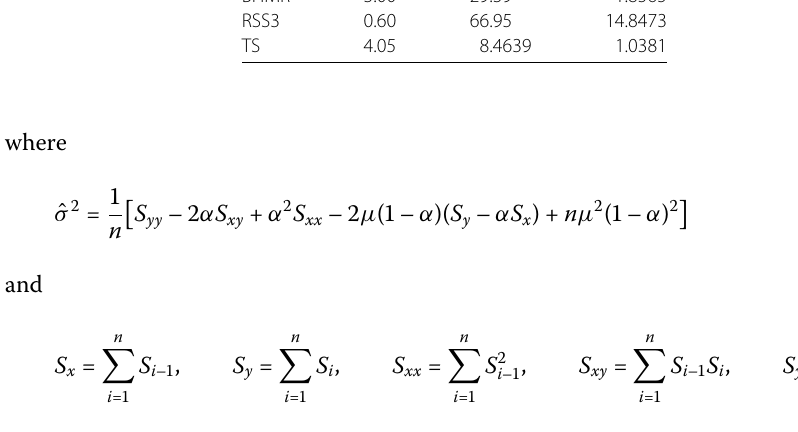
Table 1 Value of parameters used in simulation λ μ σ BHMR 3.00 29.39 1.8565 RSS3 0.60 66.95 14.8473 TS 4.05 8.4639